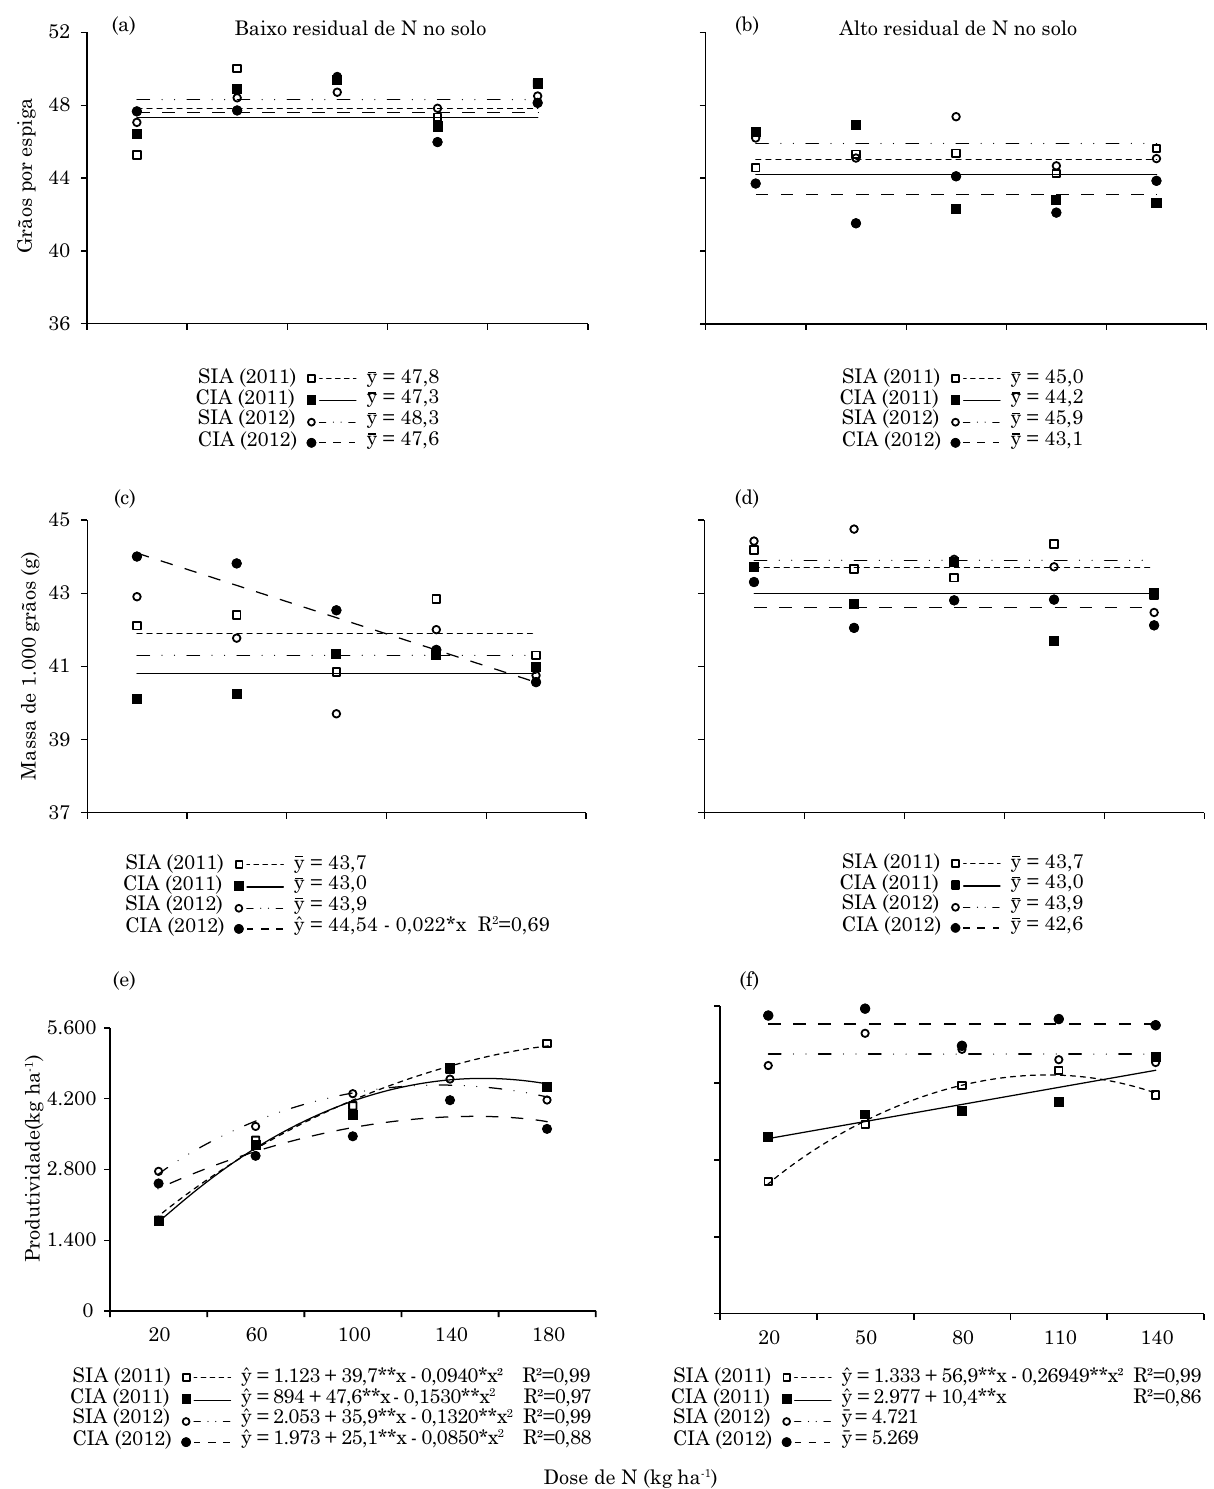
Figura 2. número de grãos por espiga, massa de 1.000 grãos e produtividade do trigo em função de doses